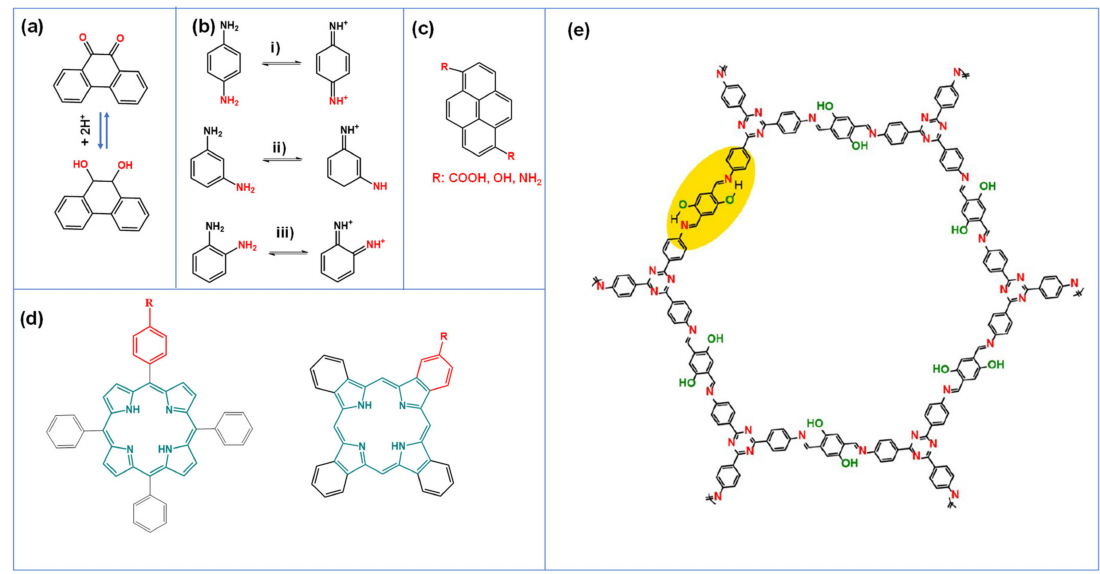
Figure 4. Chemical structure and some redox processes for ( a ) quinone type molecule, ( b ) p (i), m (ii), and oPD (iii), ( c ) pyrene molecules with different redox groups, ( d ) porphyrin and phthalocyanine macrocycles, and ( e ) N and O-containing COF. Reproduced with permission from Refs.